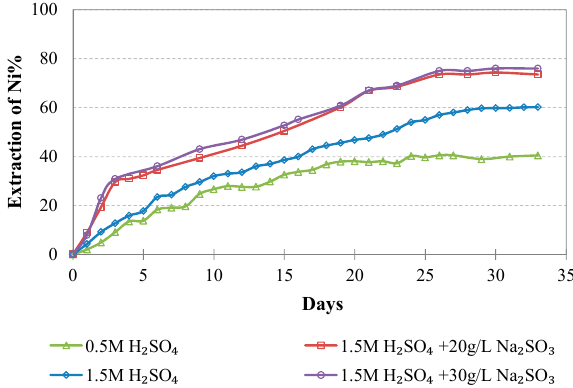
Figure 5. Evolution of % Ni extraction vs time during LAI leaching for different tests.